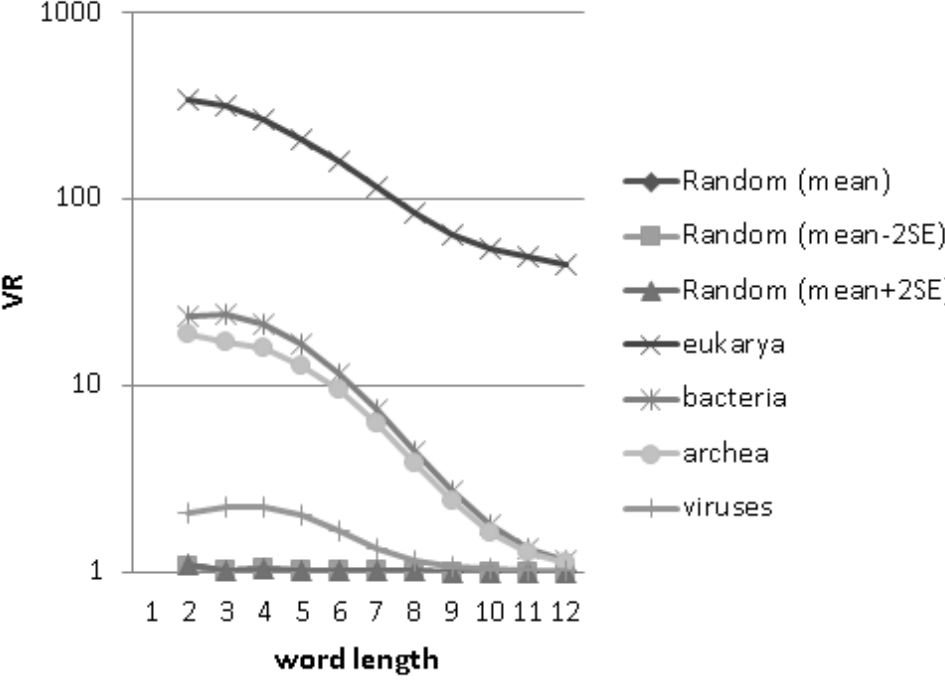
Figure 2: Mean VR values for eukarya, bacteria, archaea, viruses and random sequences (mean and mean ± 2 × standard